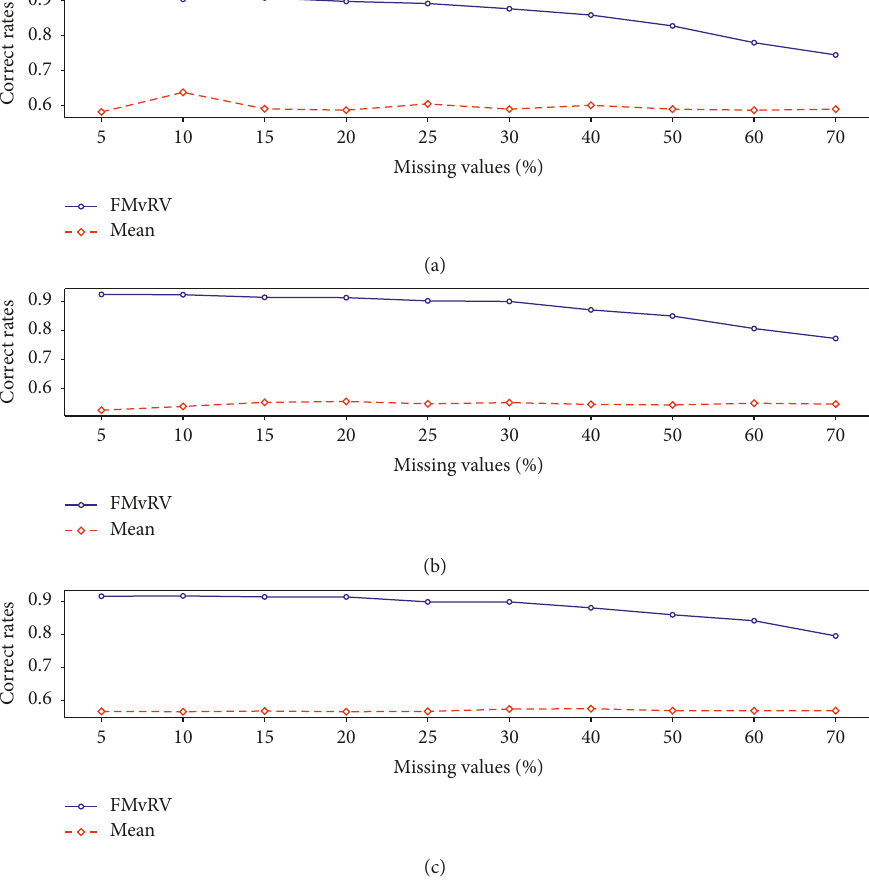
Figure 7: Comparison of the correct rates of Algorithms FMvRV and MEAN in terms of (a) AB200, (b) AB400, and (c) AB800. Table 13: Detailed information of the